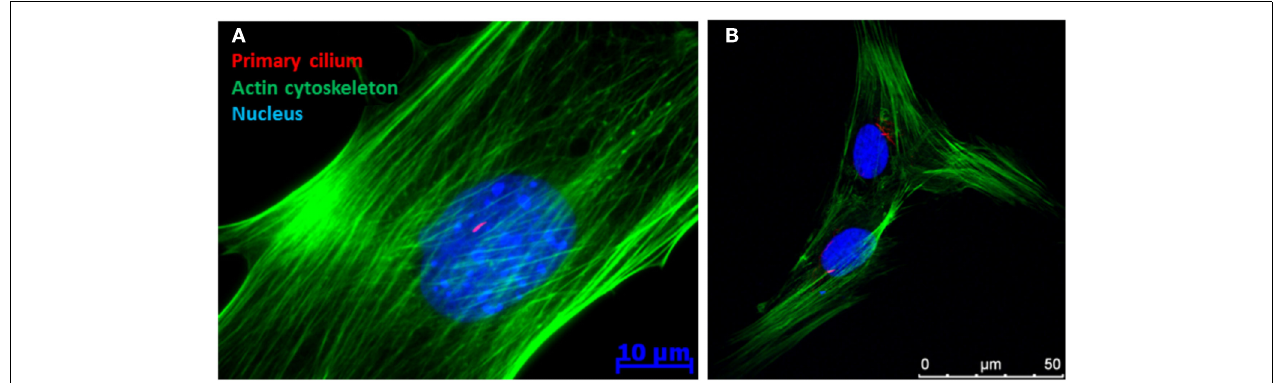
FIGURE 1 | Immunofluorescence image of a (A) MC3T3 (pre-osteoblast) and (B) human mesenchymal stem cell demonstrating the presence of a primary cilium as a rod like structure in the peri-nuclear region of the cell.